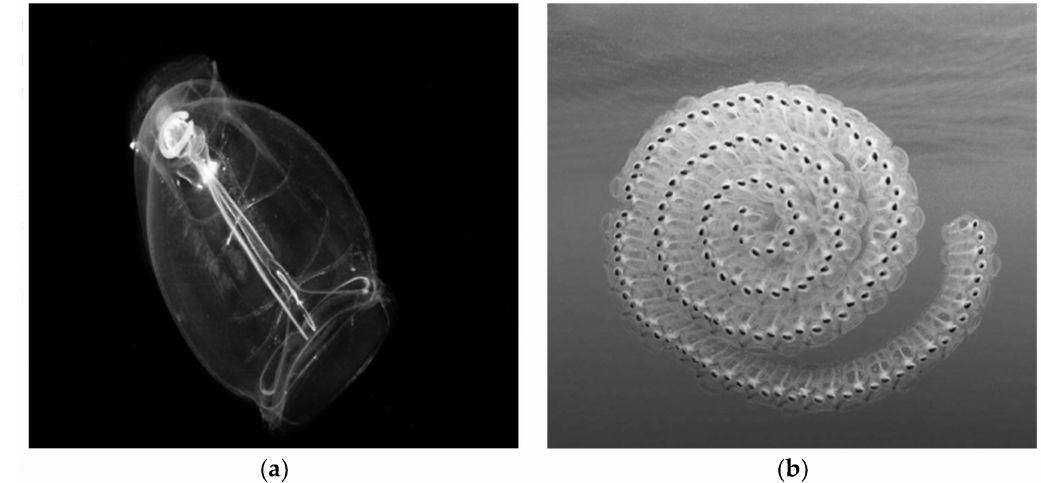
Figure 1. Individual salp and a swarm of salps (salp chain). ( a ) individual salp; ( b ) a swarm of salps (salp